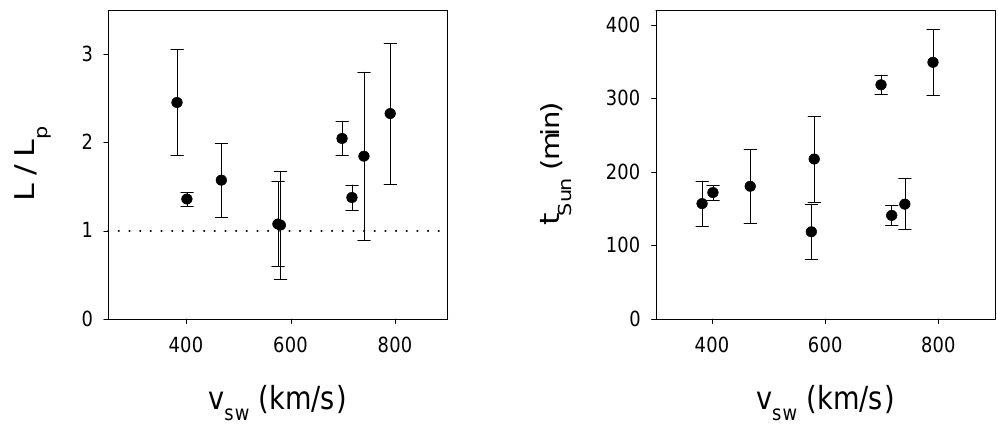
Fig. 8. Path length L and release time t Sun versus solar wind speed at